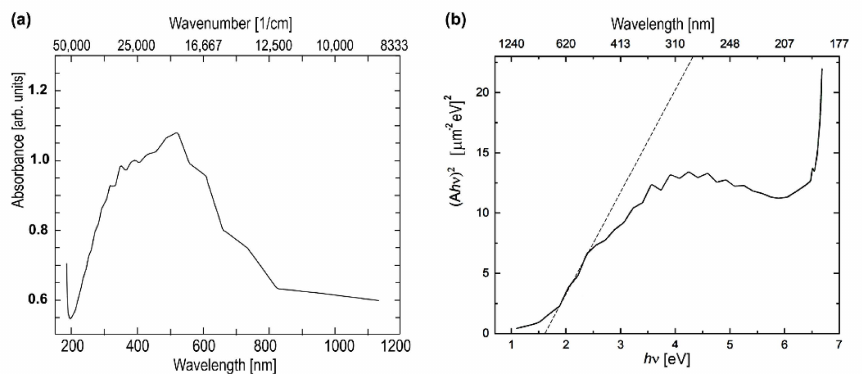
Figure 10. Absorption spectrum obtained from the top TiN x O y electrode ( a ), determination of the band gap energy E g from IR-vis-UV absorption spectra ( b